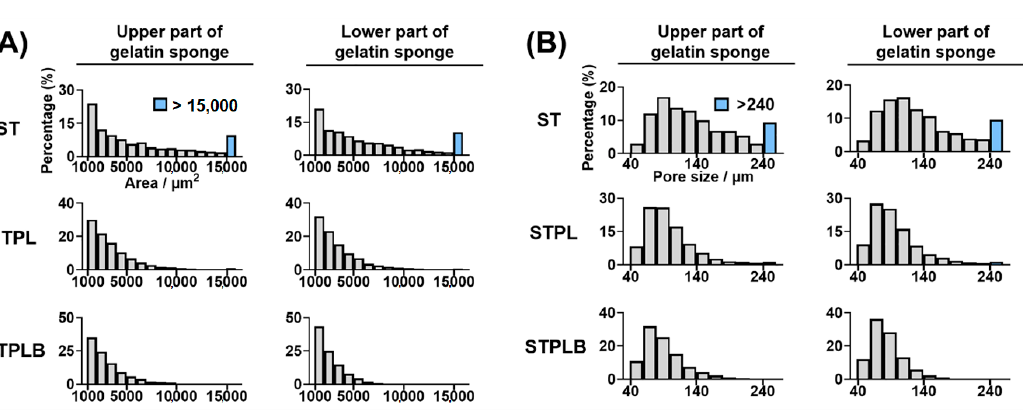
Table 1. Mean size and circularity of pores analyzed using SEM images of horizontally sectioned gelatin sponges. Upper Part of Sponge Lower Part of Sponge ST STPL STPLB ST STPL STPLB 149.2 a Diameter ( μ m) 0.19 a 0.31 b Circularity (0.03)